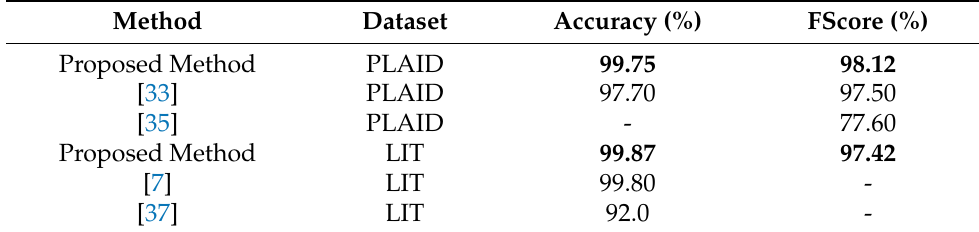
Table 5. Comparison with state-of-the-art